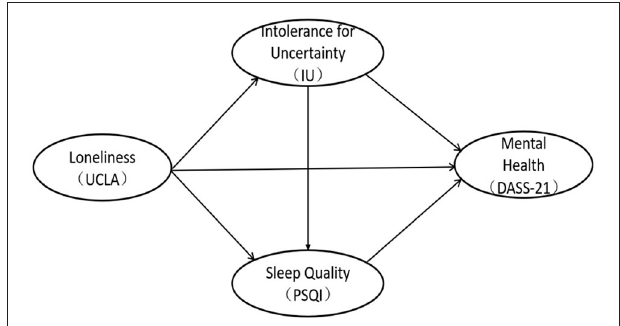
FIGURE 1 | The model of the relationship between loneliness, intolerance for uncertainty, sleep quality, and mental health.